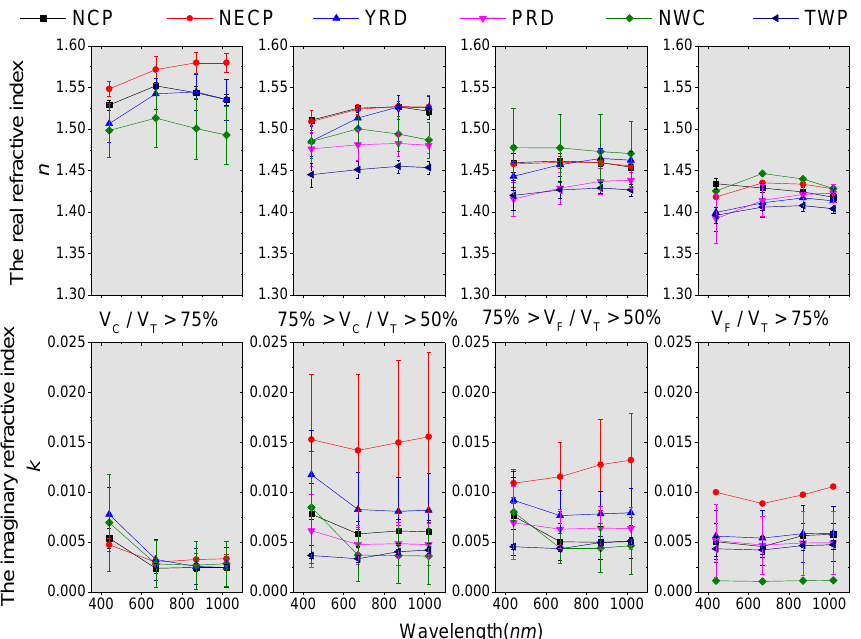
Figure 6. Complex refractive index values for different volume ratios for various regions across China; V C , V F , and V T refers to the fine-mode, coarse-mode, and total aerosol volume concentrations, respectively. 384